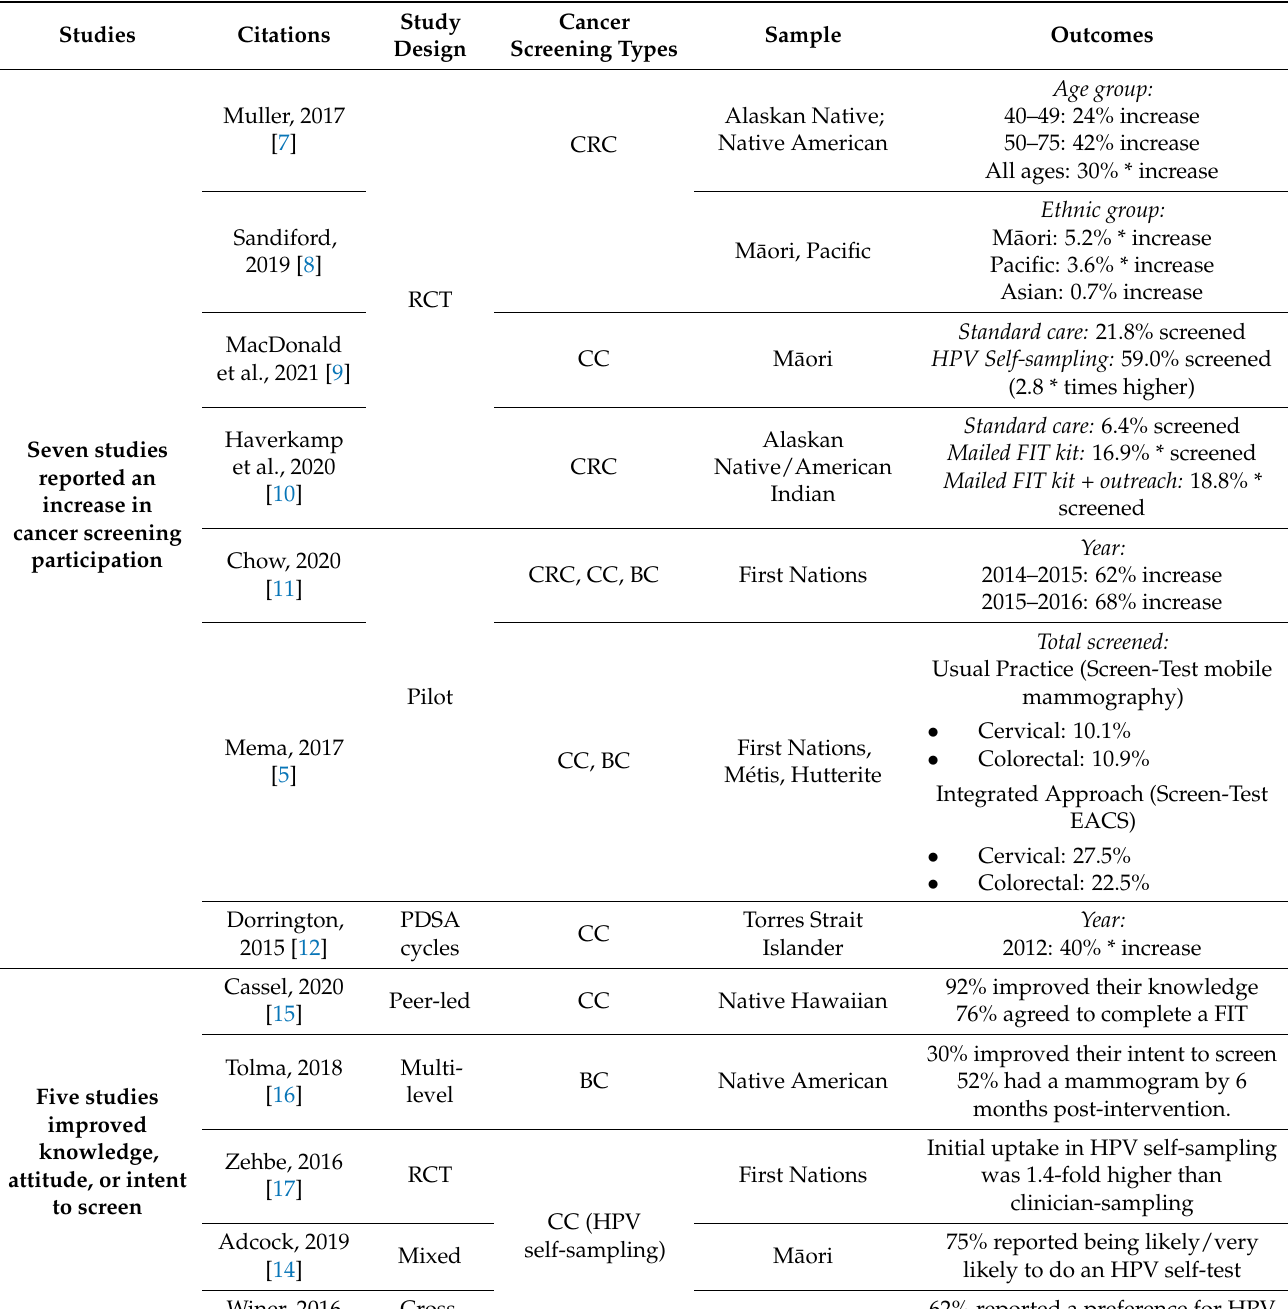
Table 6. Final summary table of included